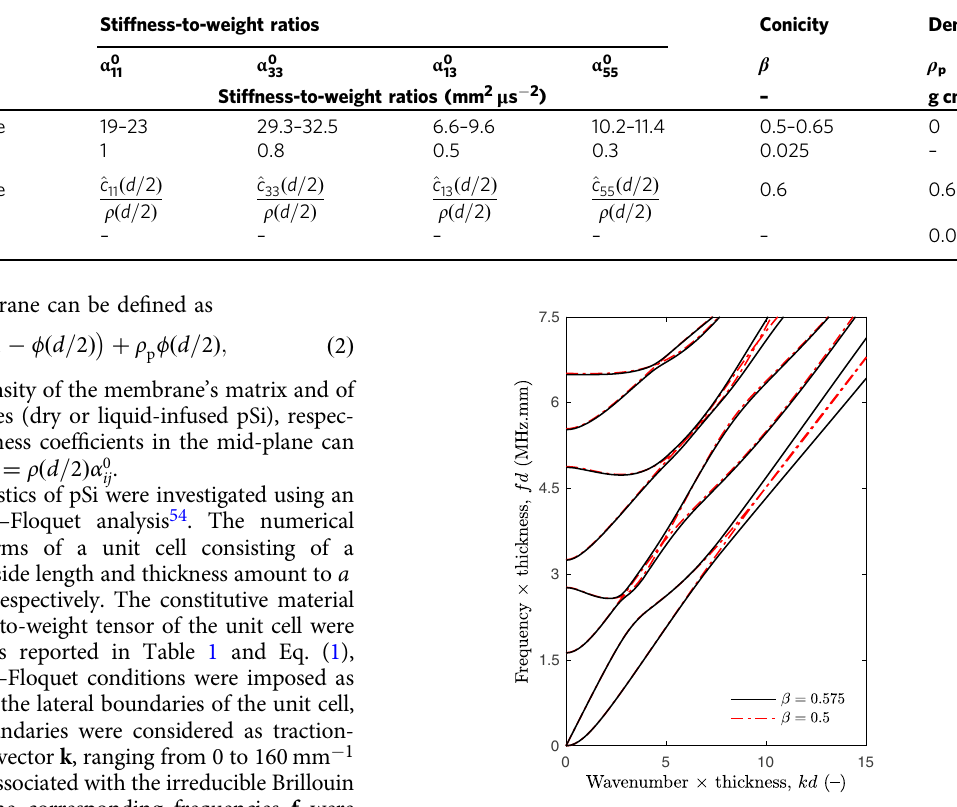
Fig. 4 Modelling of elastic guided modes. Dispersion curves in the normalised ( kd , fd )-plane calculated using Bloch – Floquet analysis for a dry nanoporous silicon membrane of thickness d : cone-shaped pores ( β = 0.575) vs cylindrical pores ( β =